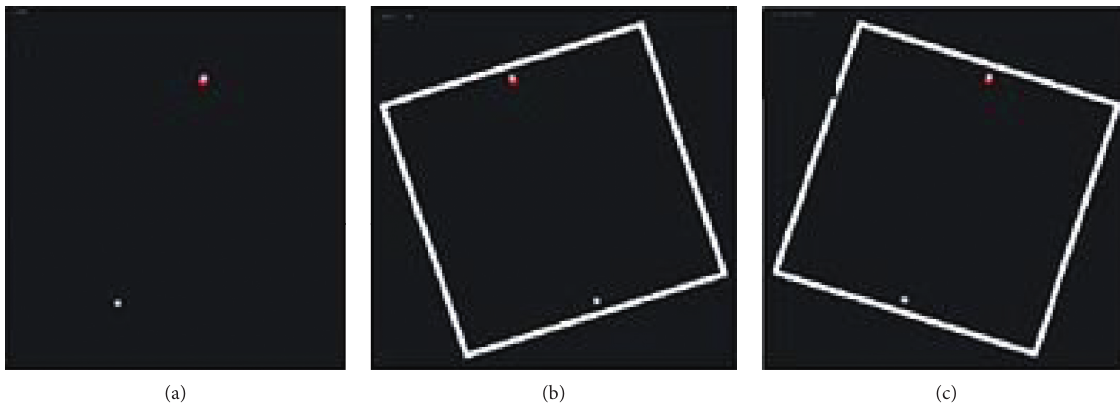
Figure 1: Presentation on the computer screen of the three frame conditions of the computerized rod and frame test (CRFT). (a) No-frame ( q, r combinations). (b) Frame − 18 ° ( u,v combinations). (c) Frame +18 ° ( w , x combinations). Table 1: The six different combinations of frame and rod conditions. Frame